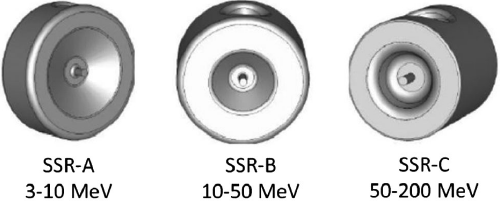
FIG. 16. Vacuum model of SSR-A, SSR-B, and SSR-C cavities.